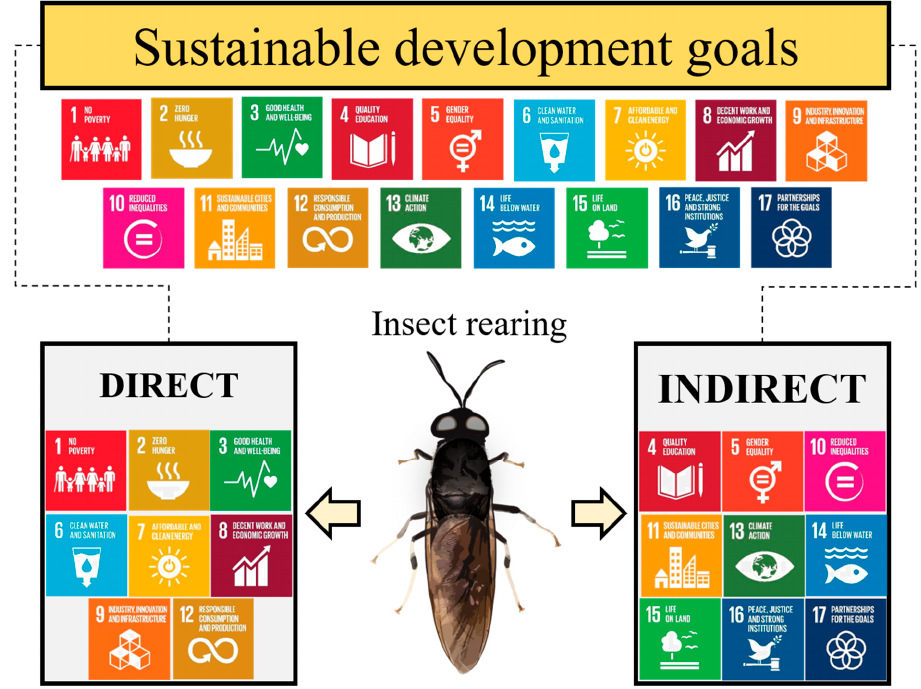
Figure 14. Insect rearing: Sustainable development goals perspective.